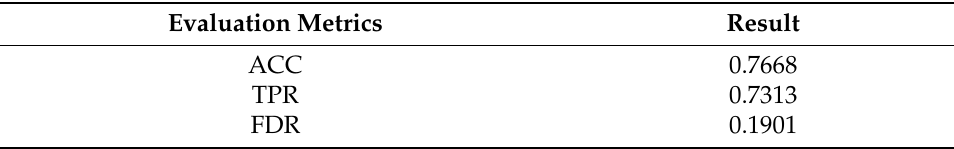
Table 2. Overall performance test